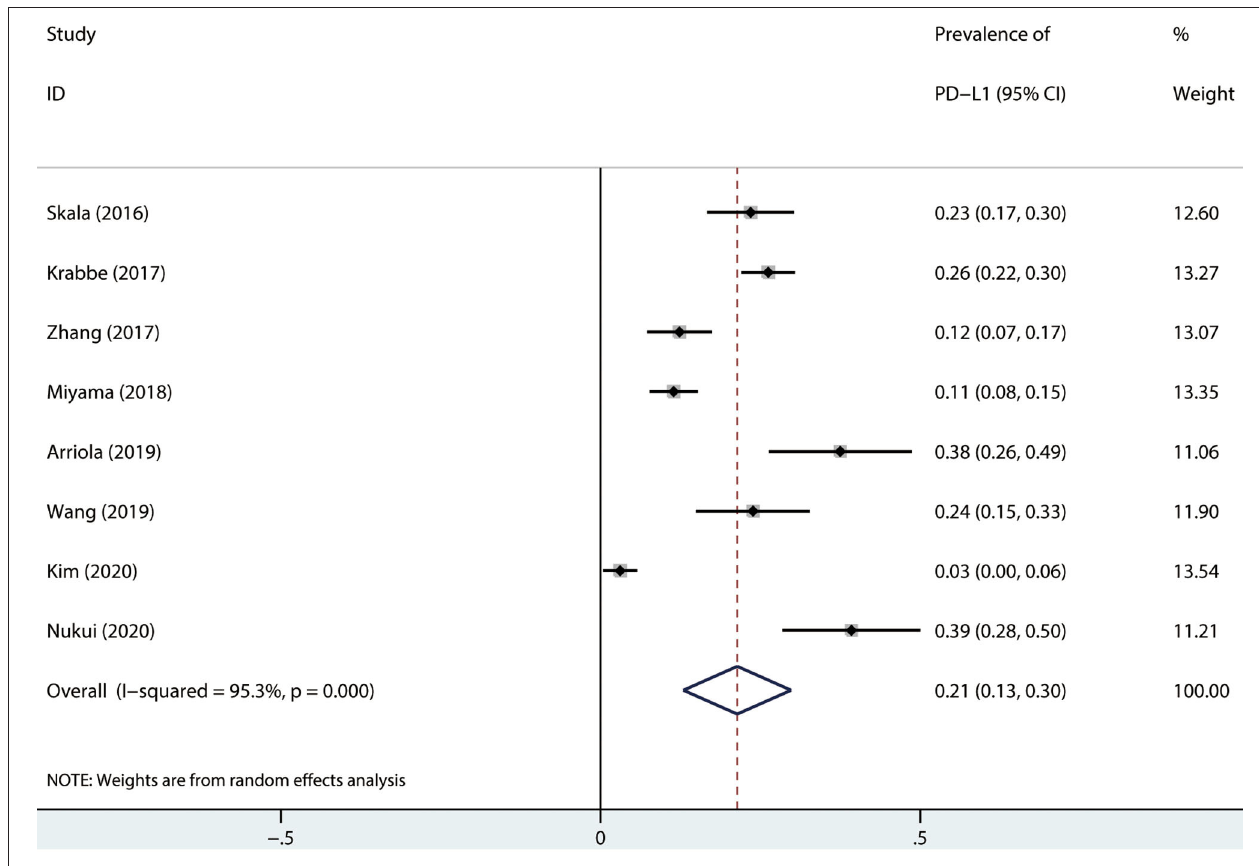
FIGURE 2 | Prevalence of PD-L1 expression in UTUC. CI, confidence